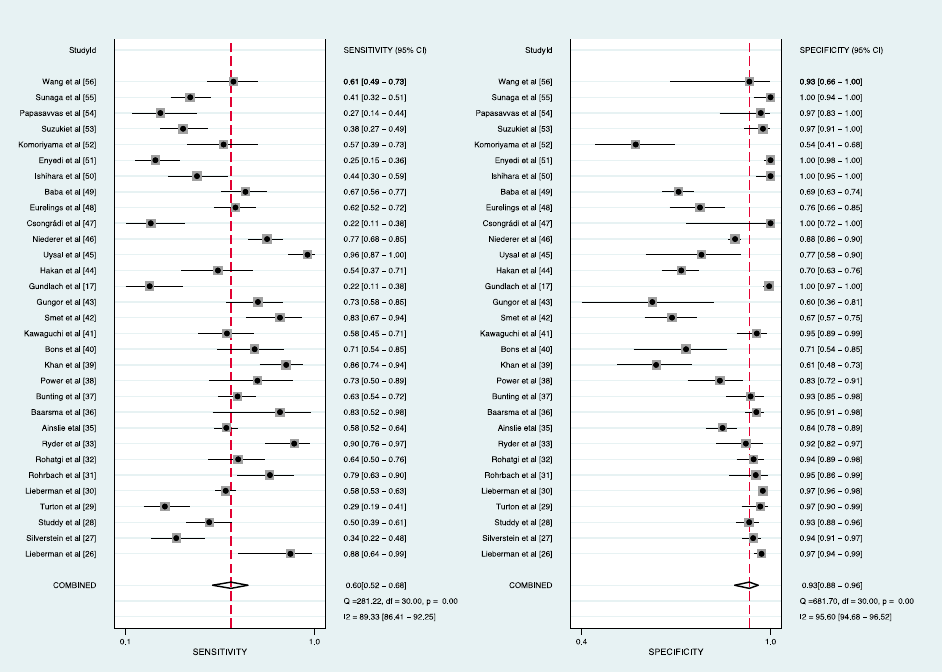
Figure 2. Forest plots of sensitivity and specificity of the sACE for diagnosing sarcoidosis. Left : sensitivity; Right : specificity.